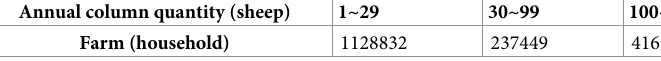
Table 6. The number of large-scale sheep farms (household) in Xinjiang. Annual column quantity